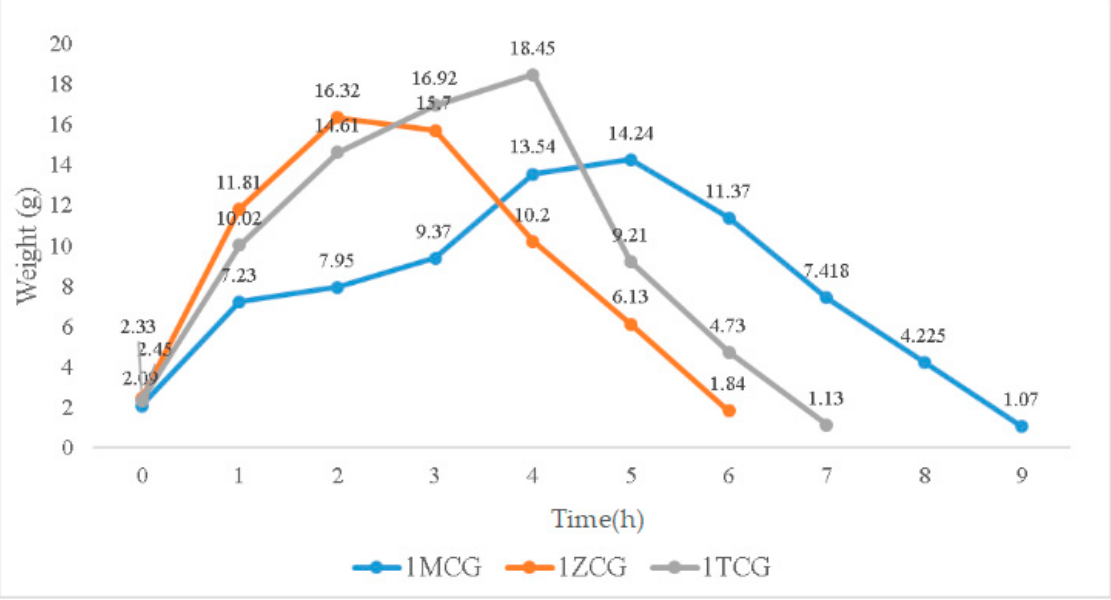
Figure 4. Swelling weight of CS/gel/mineral porous gel as related to the immersion